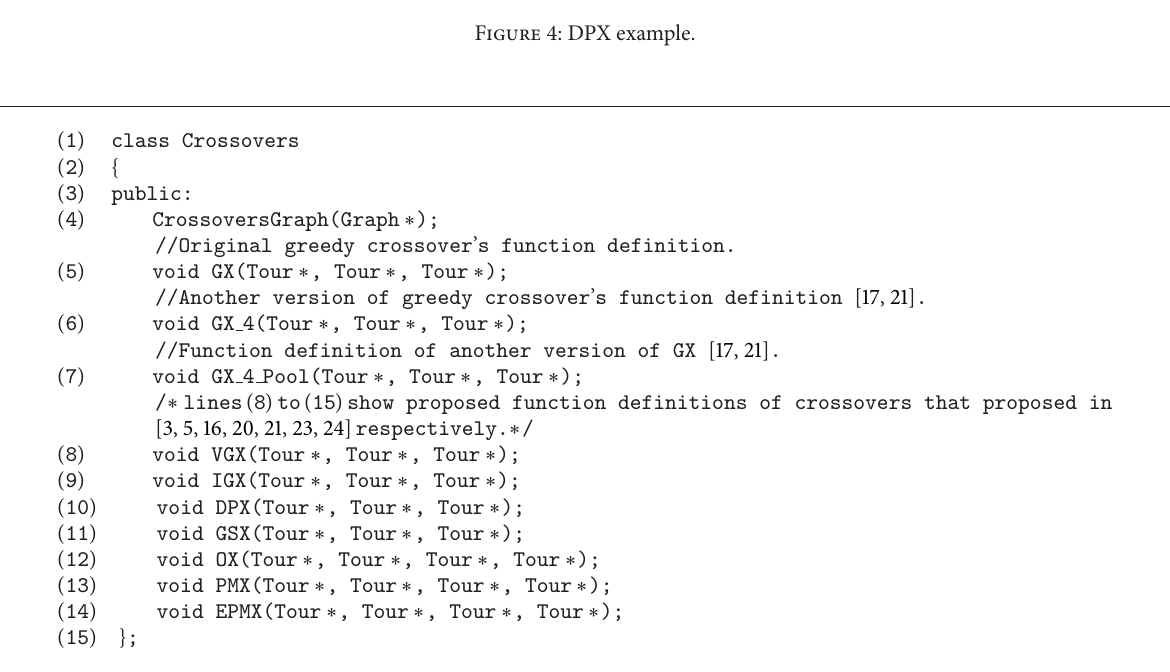
Figure 4: DPX example.